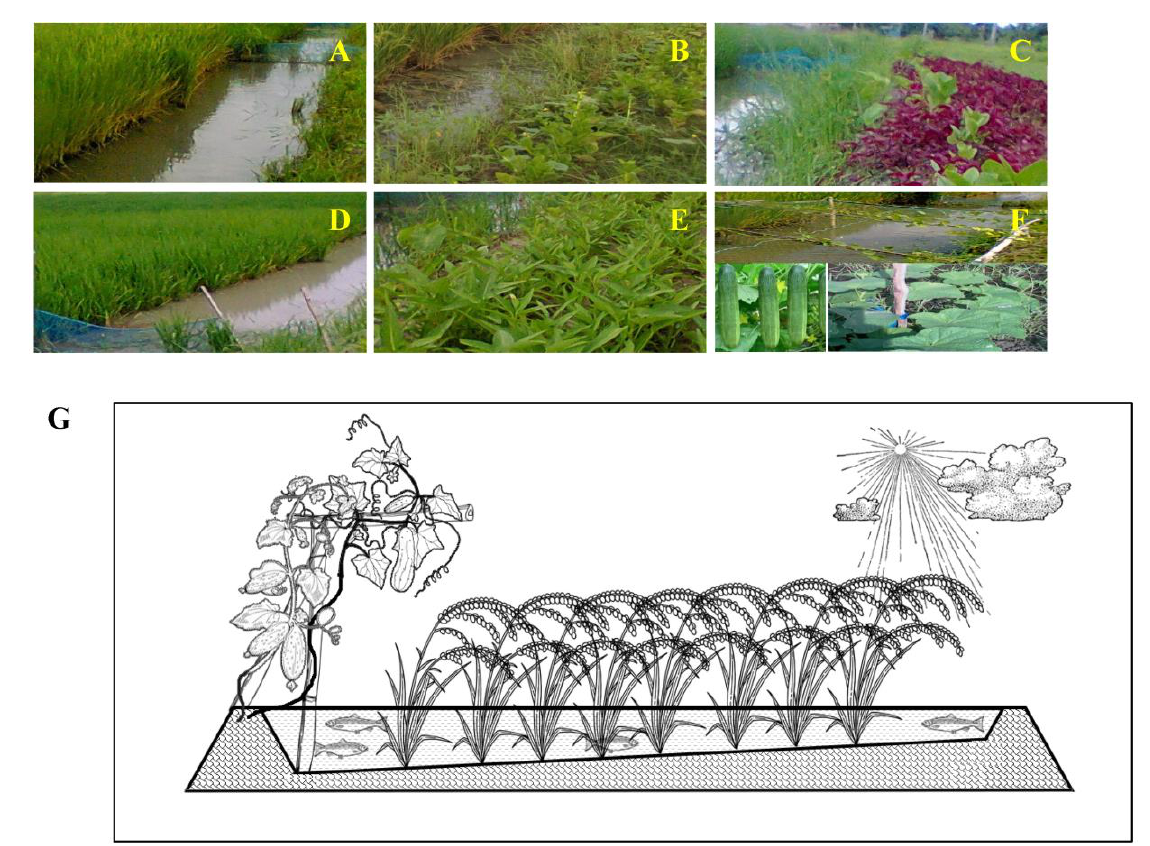
Figure 2. Combination for experiment-1 ( A = BRRI 52, B = Indian spinach, C = red amaranth) and experiment-2 ( D = BRRI 51, E = water spinach, F = cucumber, G = Methodological sketch of an integrated farming system).